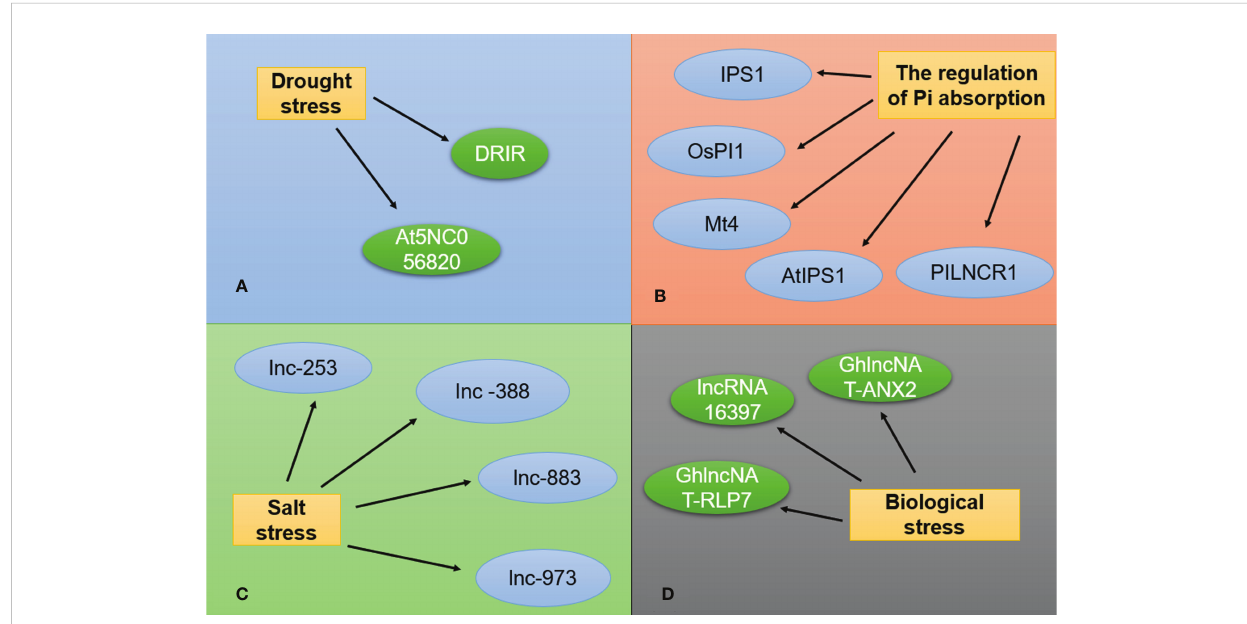
FIGURE 4 lncRNAs are involved in stress responses. (A) Two Arabidopsis lncRNAs associated with drought stress. (B) lncRNAs associated with phosphorus stress. (C) lncRNAs associated with salt stress. (D) lncRNAs associated with biotic